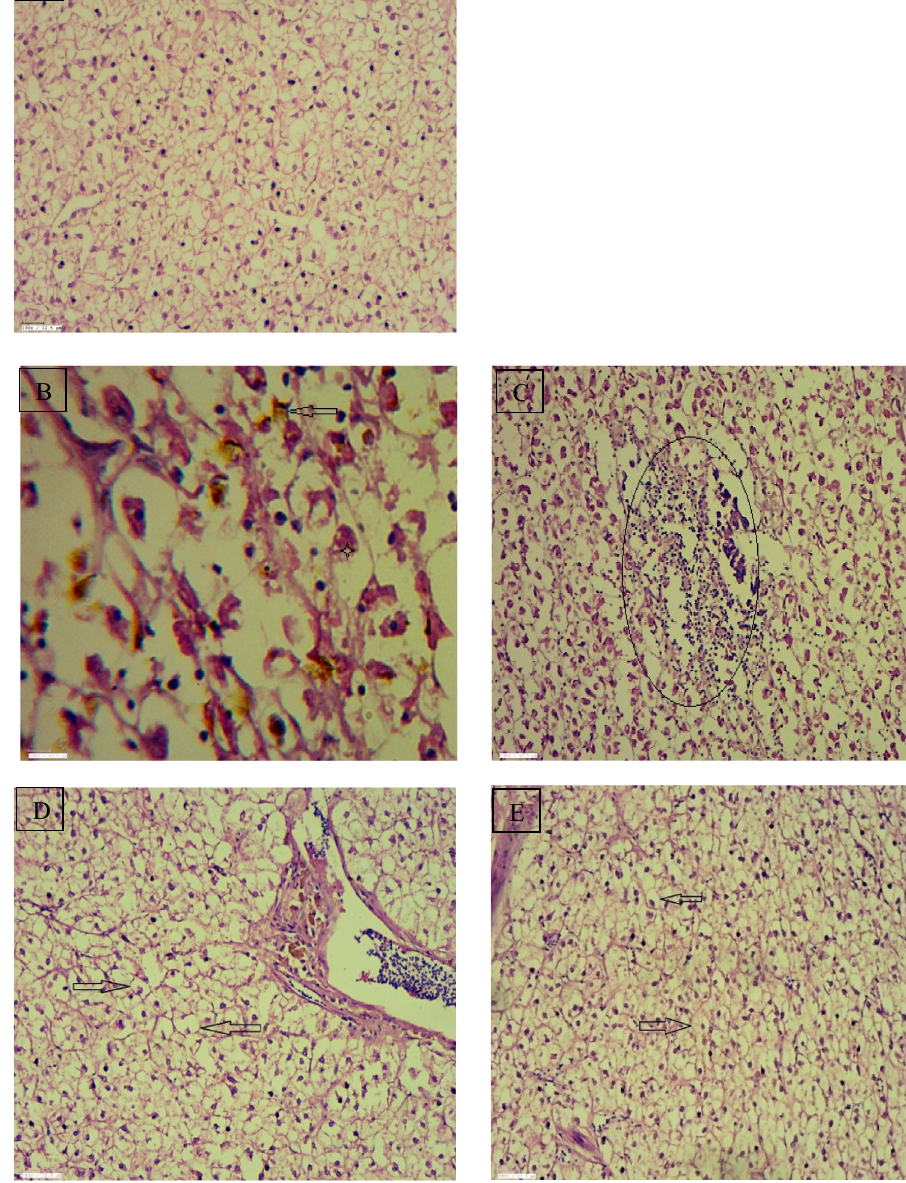
Figure 8. ( A ) Regular round shaped nuclei of hepatocytes of control fish, Liver tissue of Rita rita (Narora) ( B , C ), Necrotic changes in hepatocytes (Star) and Melanomacrophages (Arrow), Necrotic changes in hepatocytes, focal lymphocytic and macrophage infiltration (Oval). ( D , E ) Liver tissue of Rita rita (Rishikesh), Vacuolation in hepatocytes